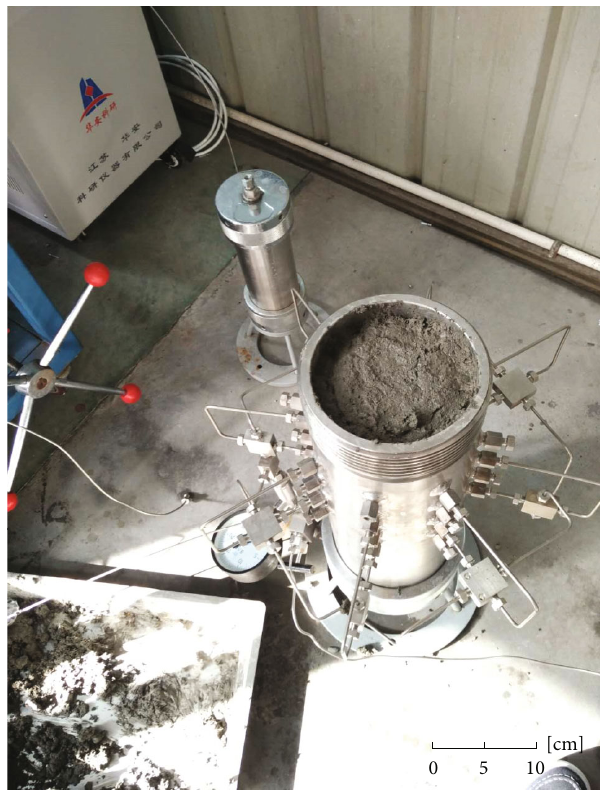
Figure 4: Clayey-silt sediments